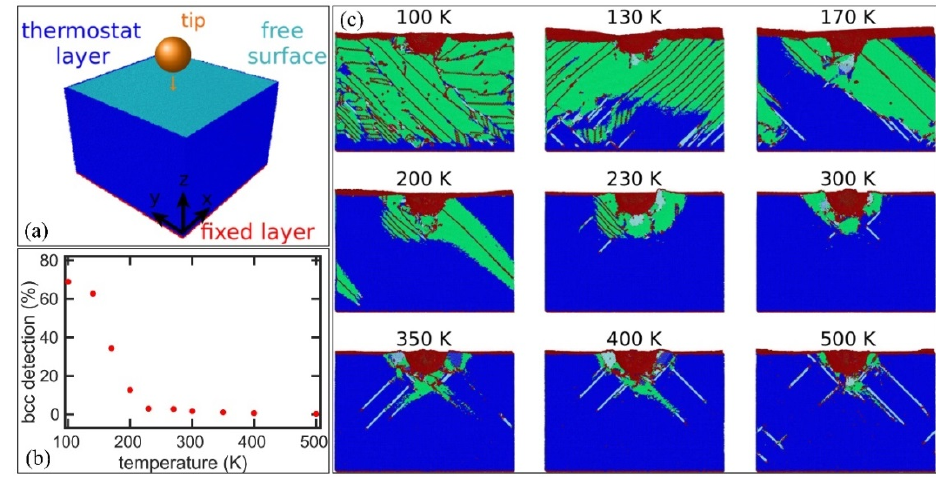
Figure 8. ( a ) Simulation setup for the indentation test with spherical indenter on austenite using molecular dynamics. ( b ) Fraction of martensite during the indentation test at different temperatures. ( c ) The transformation behavior of the austenite to martensite during compression at varying temperatures. Green color: bcc; dark blue: fcc; light blue: hcp; and red: unknown phase [113].